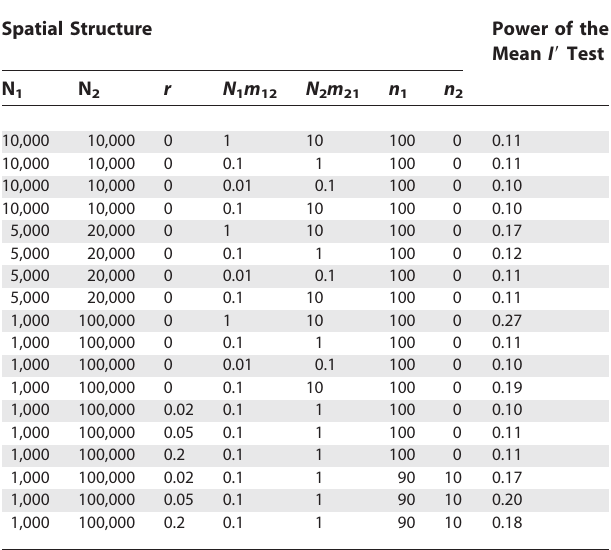
Table 3. The Power of the Mean I 9 Test to Detect Tree Imbalance under a Two-Island Model with Nonconservative Migration Spatial Structure